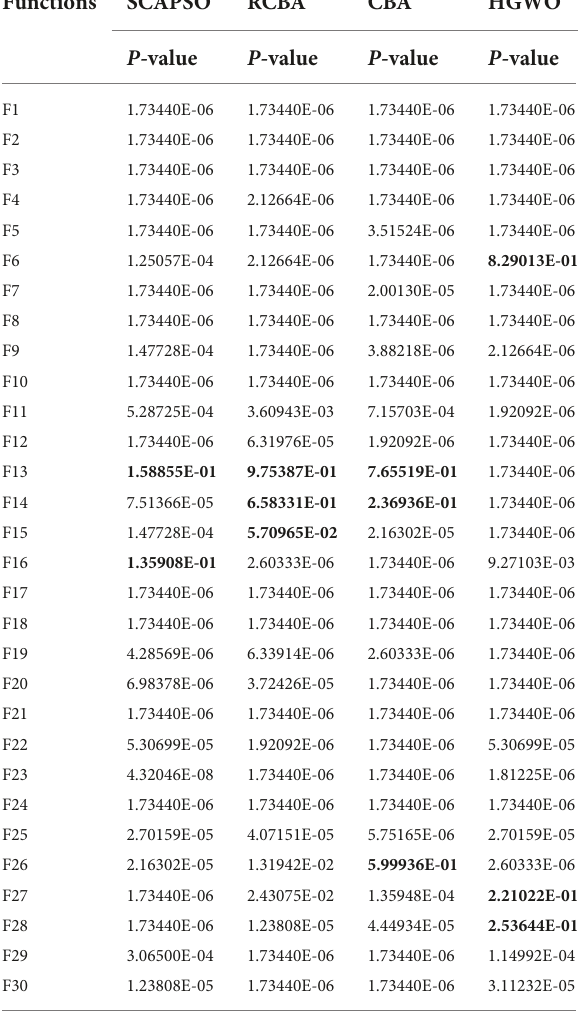
TABLE 12 The p -values of COWOA vs. well-known algorithms on the Wilcoxon